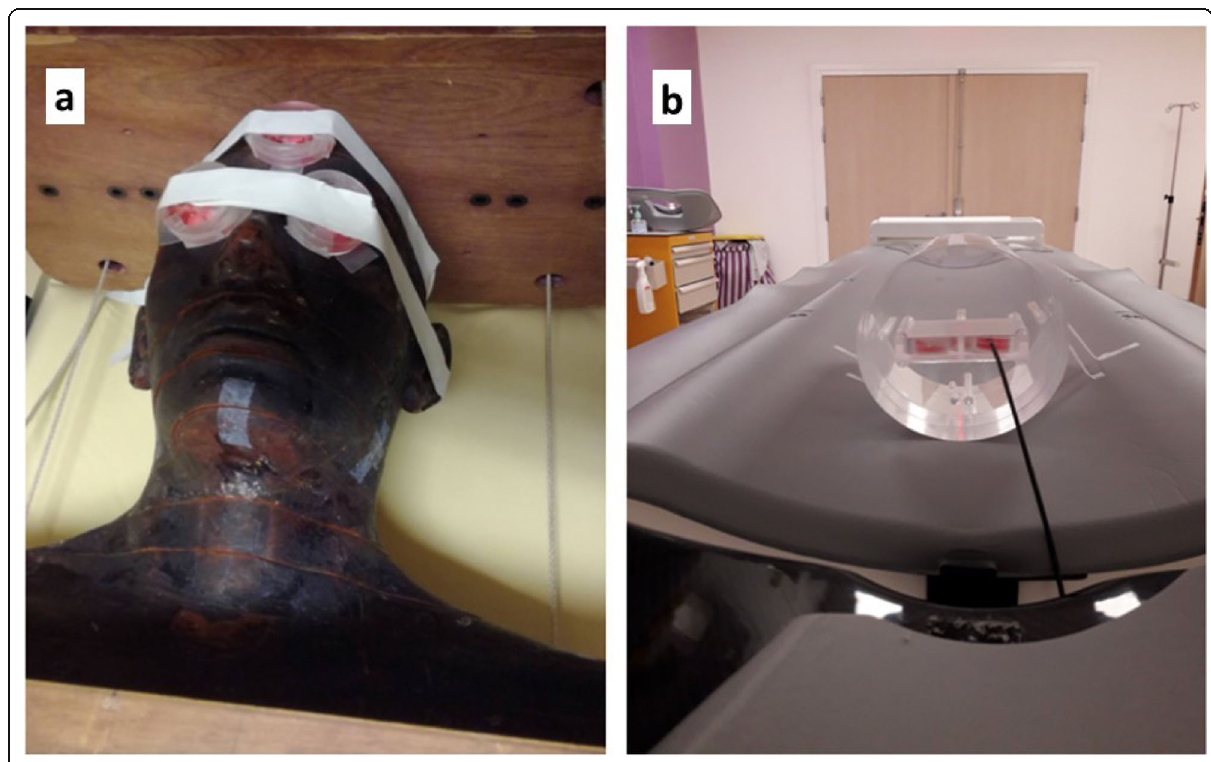
Fig. 2 Representative images of the irradiation setup. a Anthropomorphic phantom used for fibroblasts irradiation. b PMMA phantom (longer width, 16 cm) used for astrocytes irradiation . In order to be clinically relevant, fibroblasts were exposed on the surface of the anthropomorphic head phantom and astrocytes were exposed inside the PMMA phantom. PMMA Poly(methyl